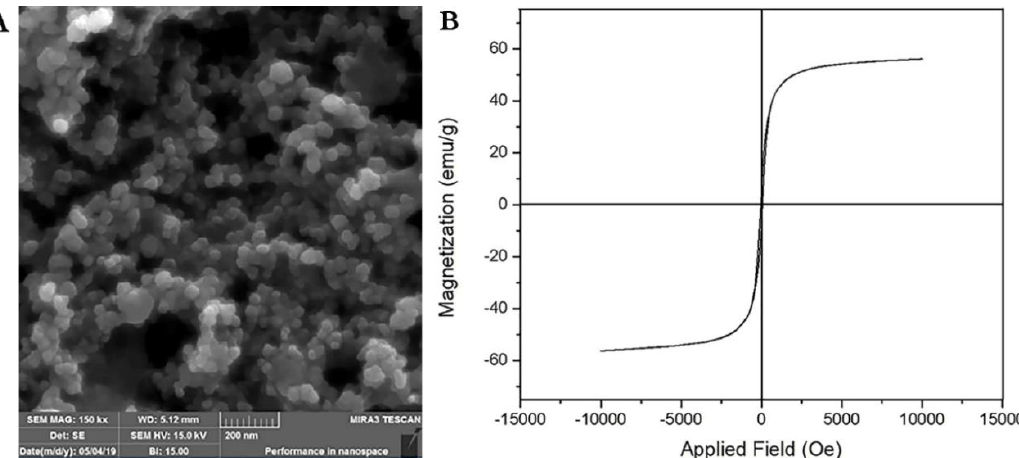
( B ) Figure 2. ( A ) Hydrodynamic diameter of magnetic nanoparticles (MNPs), PEI-MNPs, CRISPR/Cas9- PEI-MNPs in the presence of water and DMEM at pH 7.0 (mean ± S.D.; n = 3). ( B ) Zeta potential of magnetic nanoparticles (MNPs), PEI-MNPs, CRISPR/Cas9-PEI-MNPs in the presence of water and DMEM at pH 7.0 (mean ± S.D.; n = 3).